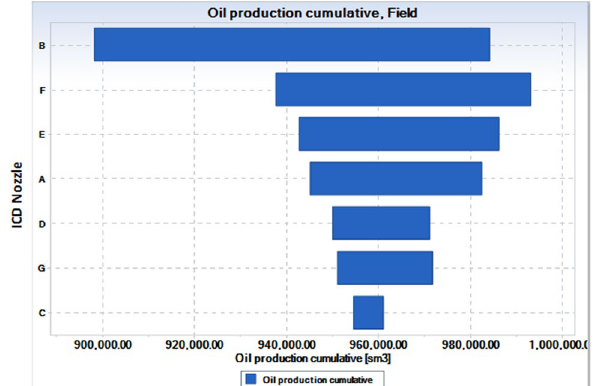
Fig. 8 Sensitivity results of compartment length